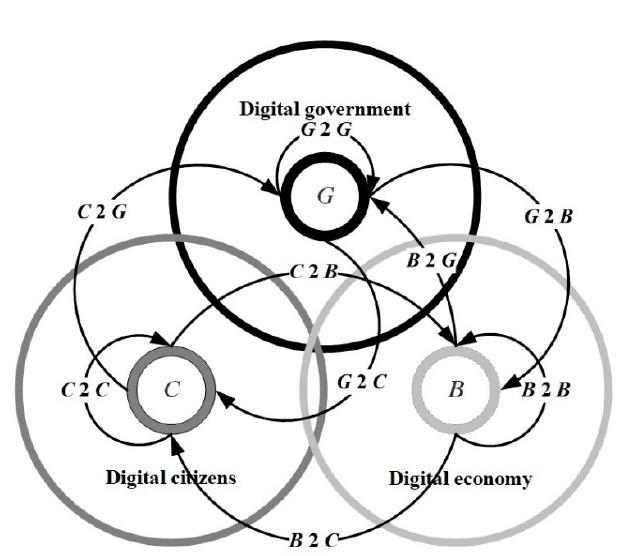
Figure 2. A generalized model of the information society used for assessment of digitalization levels.